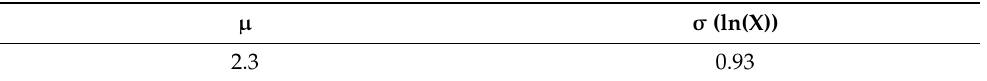
Table 4. Mean and standard deviation for the ln(x) distribution, with x expressed in g/ton of crude oil processed.